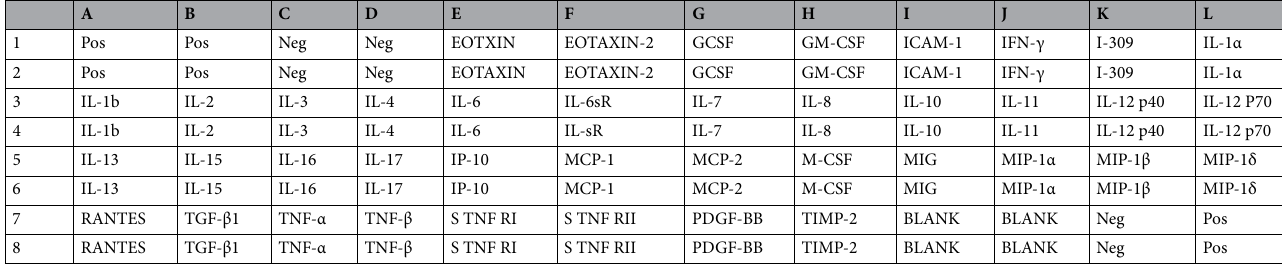
Table 4. Array map of the spots on the human inflammatory antibody array membrane (40